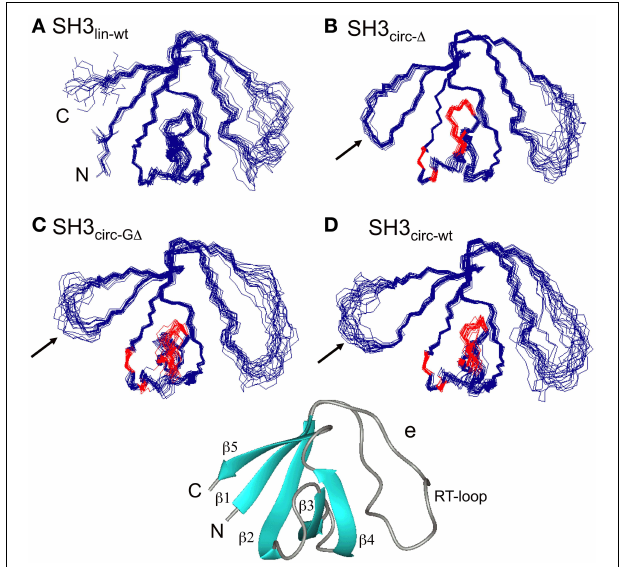
FIGURE 1 | The ensembles of 20 lowest-target-function structures (backbone) for the linear (A) and circular SH3 constructs: (B) SH3 circ - 1 , (C) SH3 circ - G 1 , and (D) SH3 circ - wt . A cartoon representation of the 3D structure of the linear N-terminal SH3 domain of c-Crk is shown in (E) . For the circular constructs the arrows indicate the location of the cyclization loop. Colored red are those residues exhibiting conformational exchange in the submillisecond time scale (cf. Figures 5 , 6 ). The figure was prepared using MolMol (Koradi et al.,